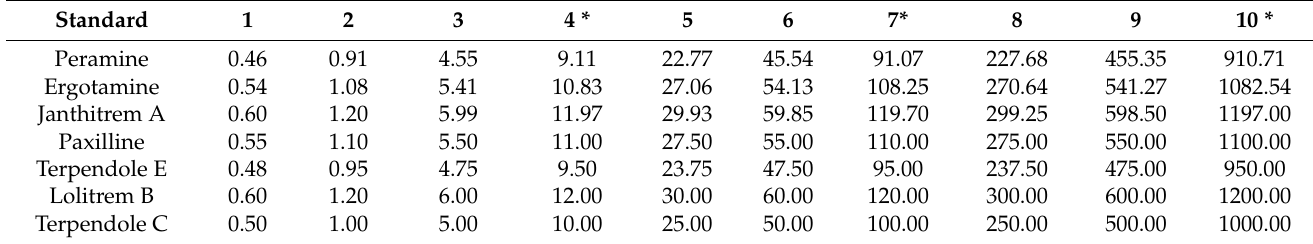
Table 1. The linear range of alkaloid standards